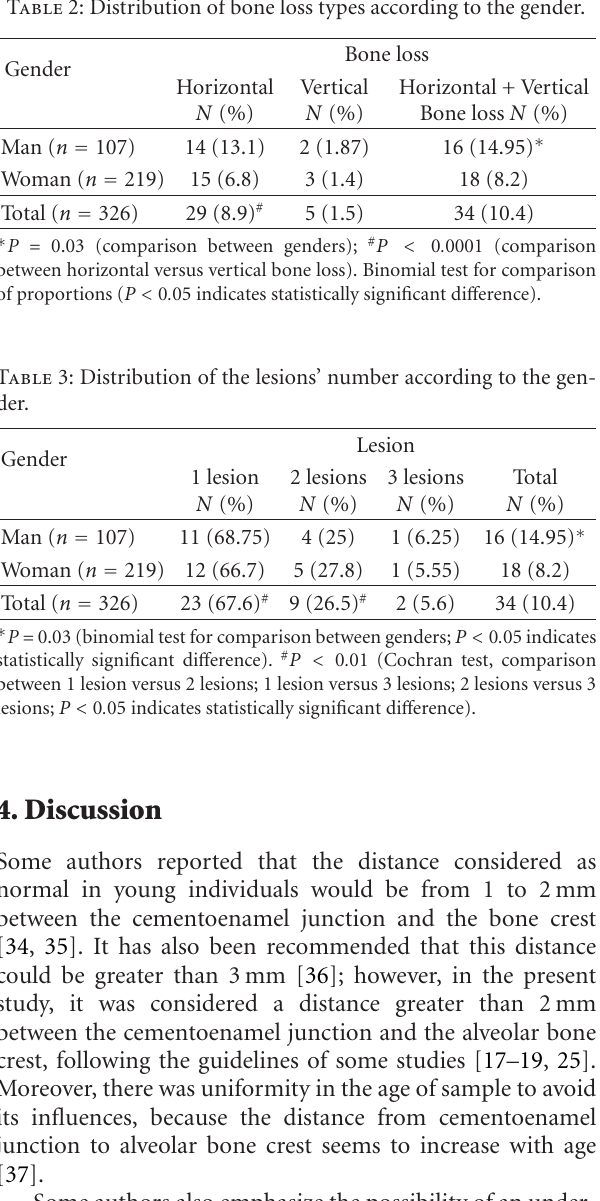
Table 2: Distribution of bone loss types according to the gender. Gender